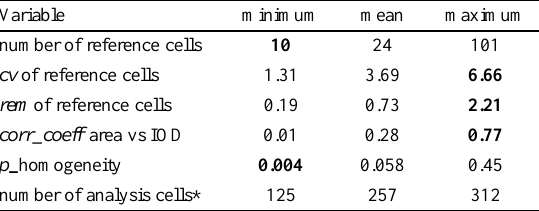
QC variables of individual measurements from 17